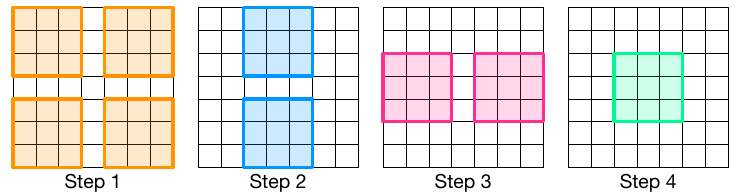
Figure 9. The convolution operation is divided in different steps. In each step only non-overlapping convolution windows are executed in